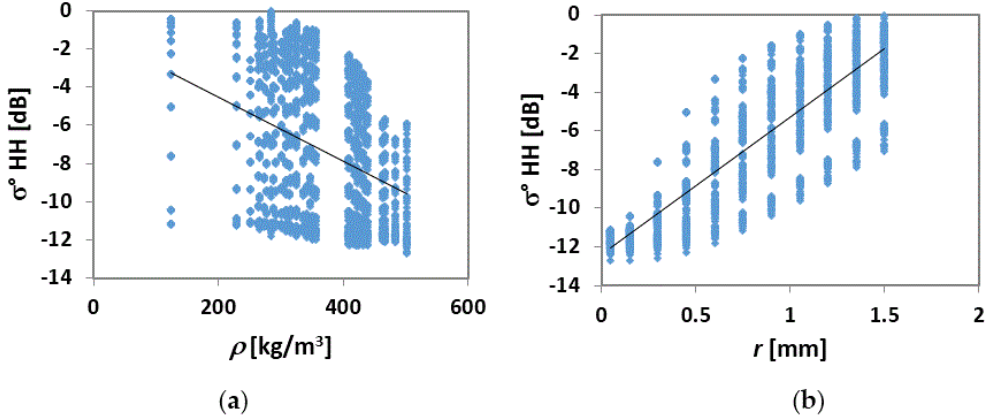
Figure 6. ( a ) σ ◦ (HH) values vs. ρ derived from different SD values of the dataset collected on Monti Alti di Ornella. The obtained regression line is σ ◦ = − 0.017 ρ − 1.16, R 2 = 0.14; ( b ) σ ◦ vs. grain radius, r . The regression line is σ ◦ = 7.1 r − 12.4, R 2 = 0.78.